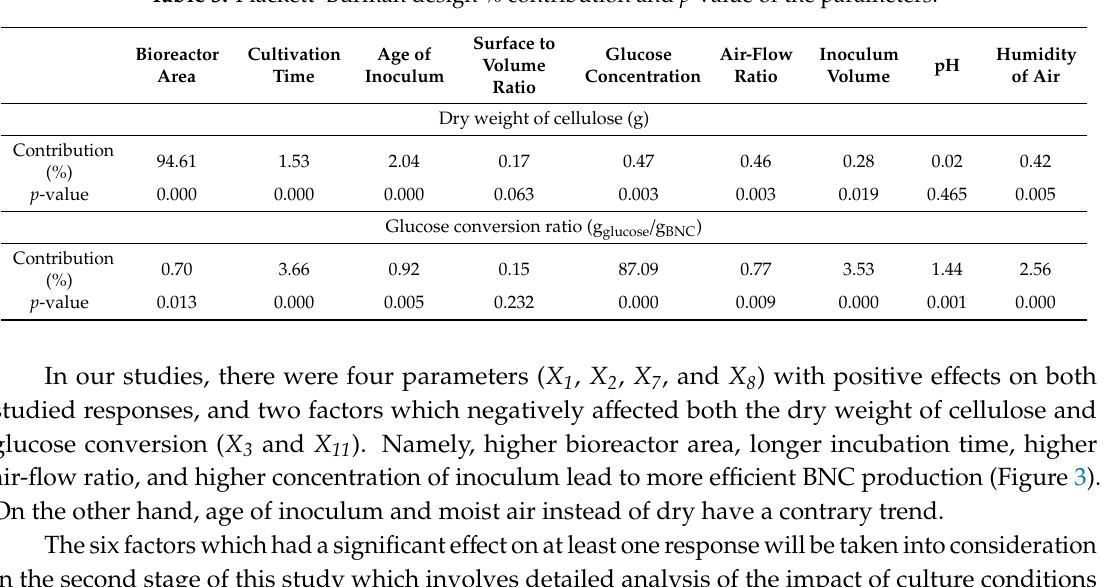
Table 3. Plackett–Burman design % contribution and p -value of the parameters.